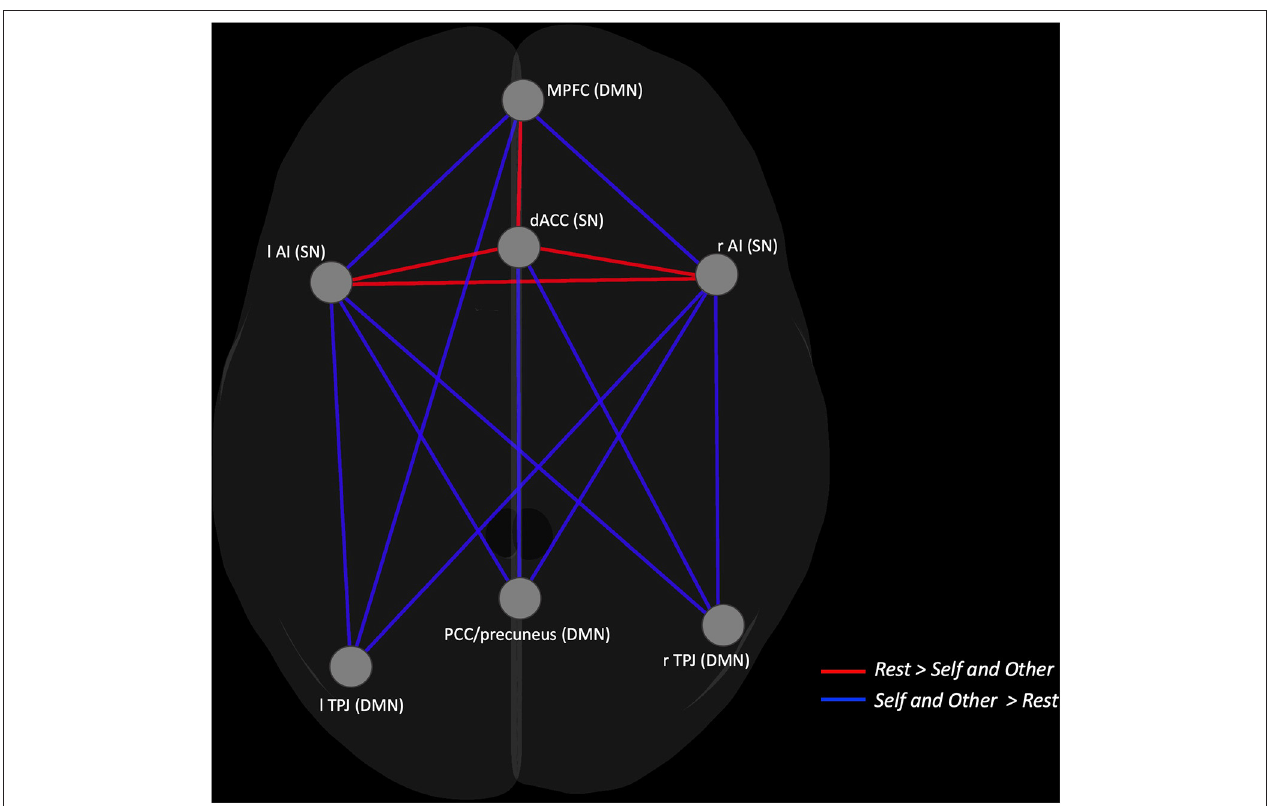
FIGURE 4 | Graphical representation of the ROI-to-ROI contrast showing the nodes with increased FC in the Self and Other conditions (blue lines) compared to the Rest and increased FC in the Rest condition (red lines) compared to the Self and Other.